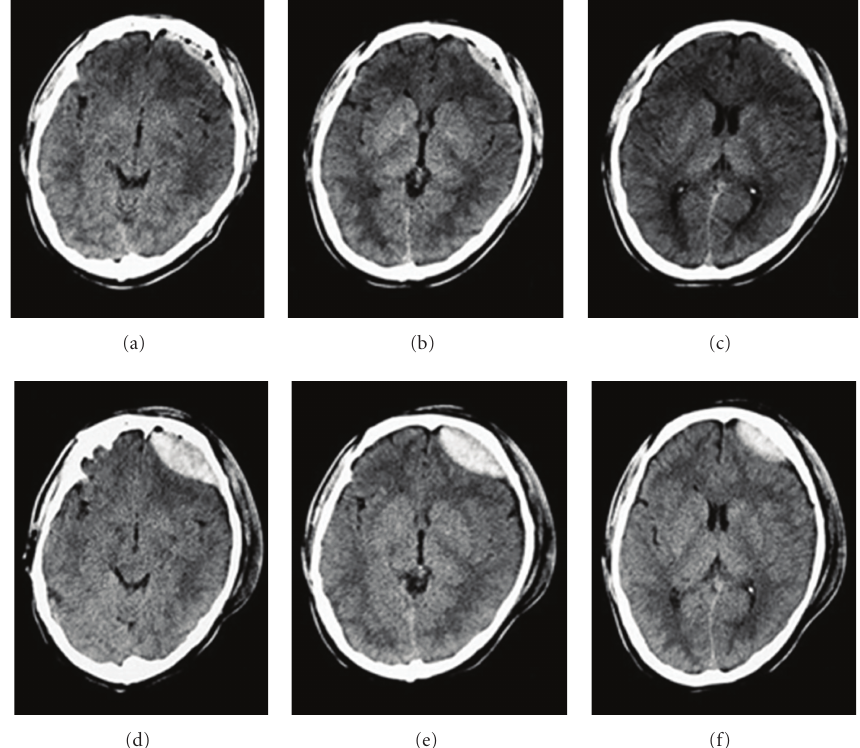
Figure 1: Case 1. Progressive epidural hematoma in a 32-year-old man after motor vehicle collisions. (a), (b), and (c): Initial CT image obtained 2 hours after-injury, demonstrating a small epidural hematoma in the left frontal. (c), (d), and (e): The second CT scan obtained 6 hours after-injury revealed an unambiguous increase in hematoma